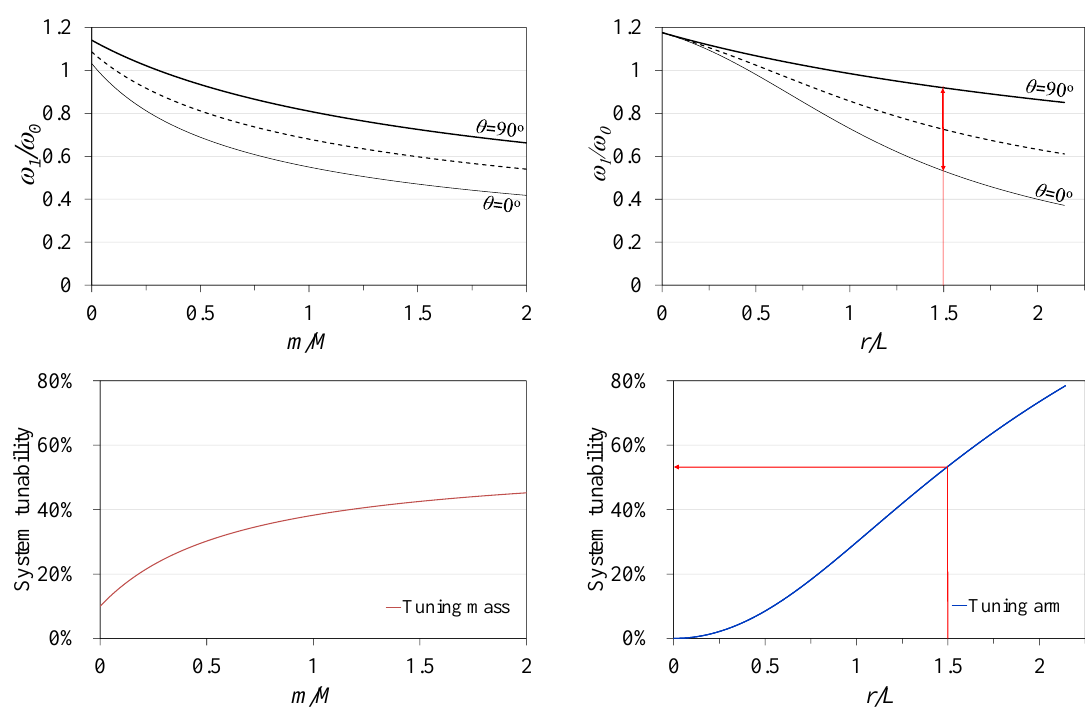
Figure 6. Generic dimensionless parameter effects on system tunable response and tunability